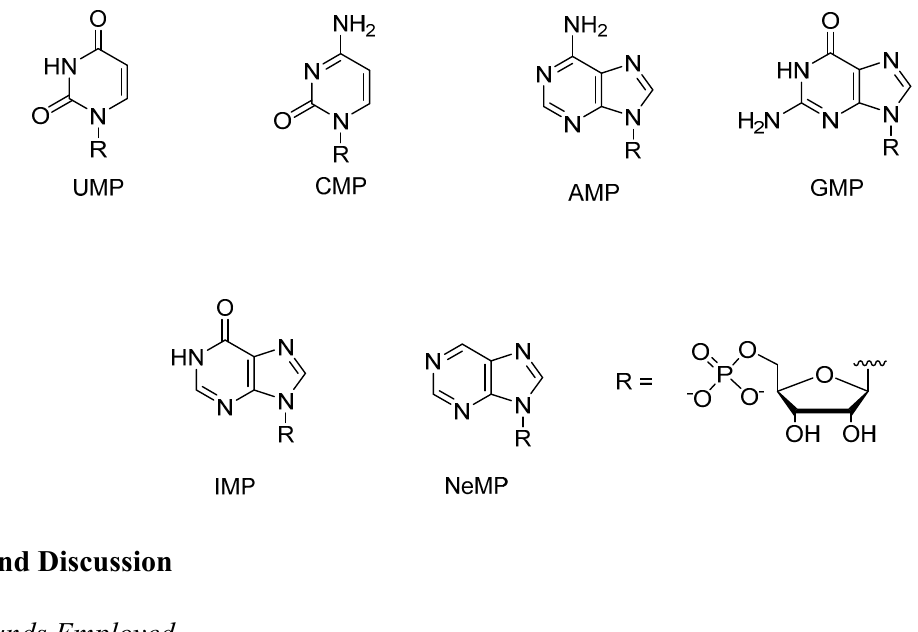
Figure 2. Structures of nucleoside 5'-monophosphates used in the present